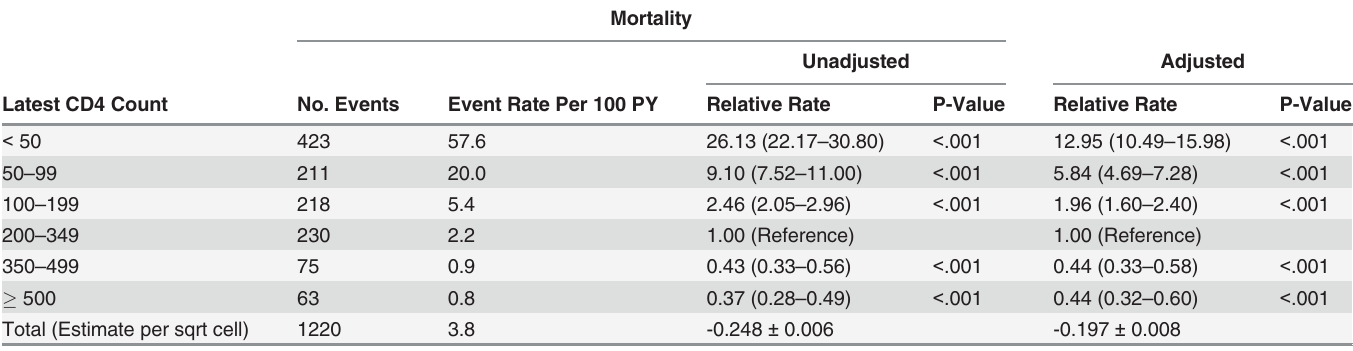
Table 2. Mortality Rates by Latest CD4 Count (cells/mm 3 ) for Phidisa Participants: Mortality Cohort.